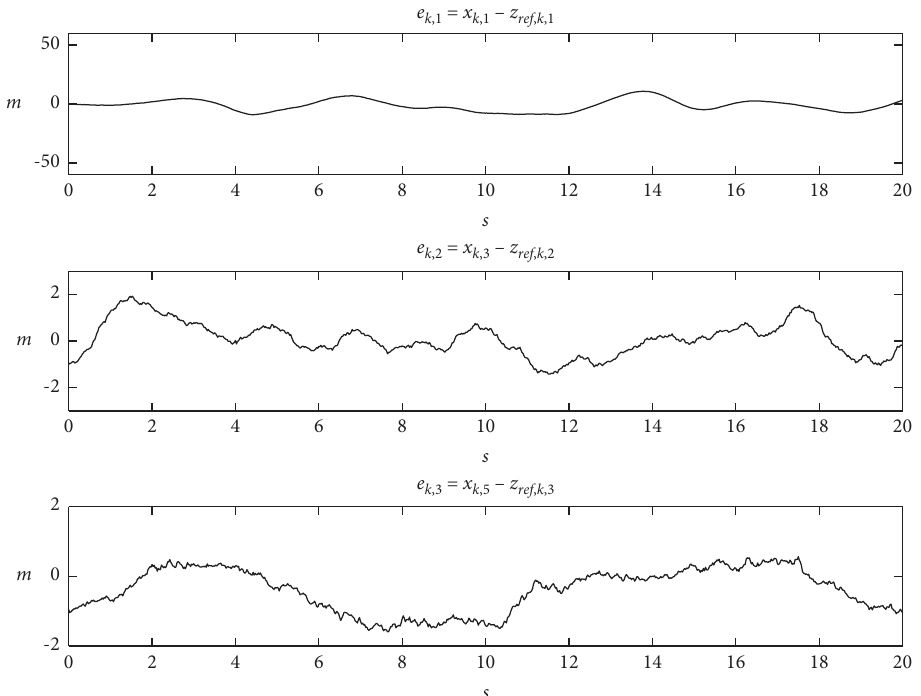
Figure 11: Tracking errors for random references and random